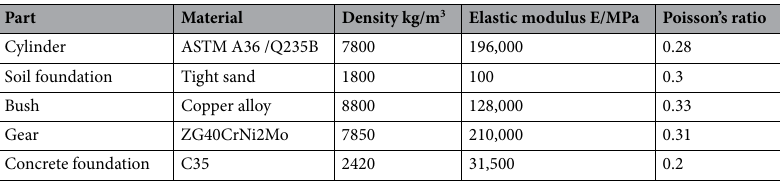
Table 1. Basic parameters of ball mill foundation model.